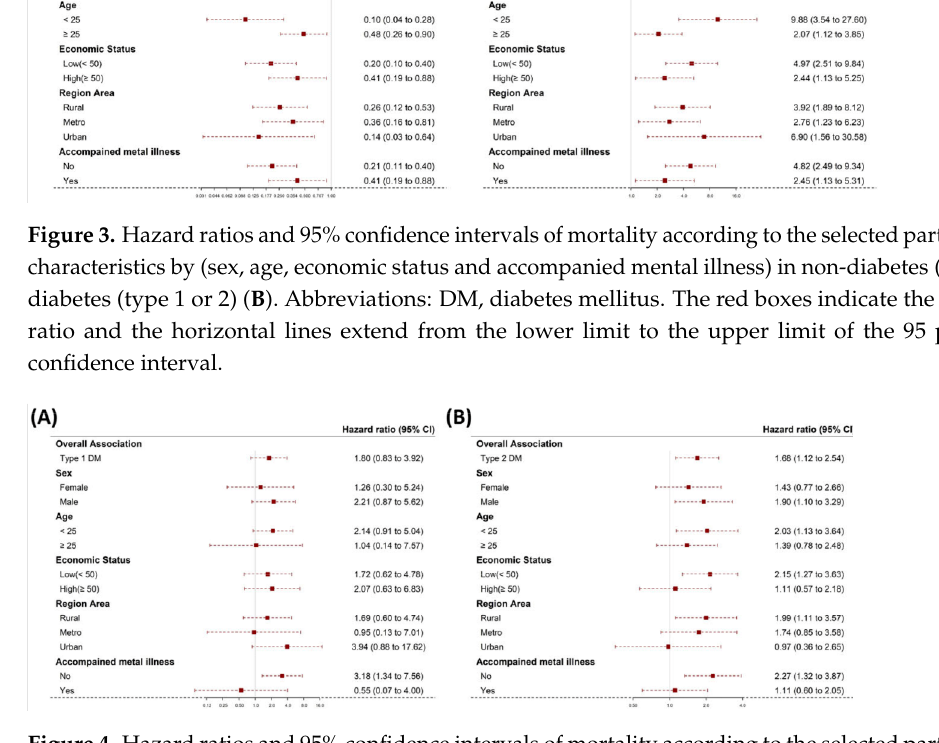
Figure 4. Hazard ratios and 95% confidence intervals of mortality according to the selected participant characteristics by (sex, age, economic status and accompanied mental illness) in diabetes type 1 ( A ) and 2 ( B ). Abbreviations: DM, diabetes mellitus. The red boxes indicate the hazard ratio and the horizontal lines extend from the lower limit to the upper limit of the 95 percent confidence